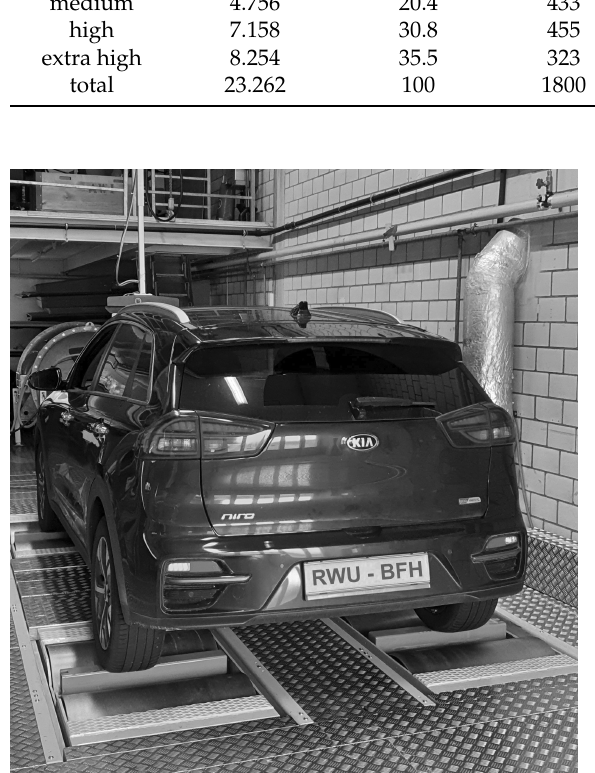
Figure 2. Kia e-Niro on the chassis dynamometer at Berner university of applied sciences. The measured energy consumption E WLTC in the cycle measurements includes the charging losses as specified by the WLTP and is equal to the charged energy E C per 100 km. Both parameters are determined by measuring the recharged energy after completing the WLTC using appropriate power measurement